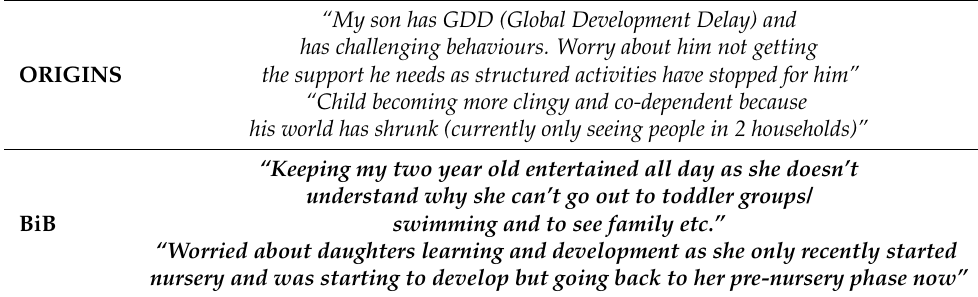
Table 4. Concerns about children’s education and behaviour: Sample